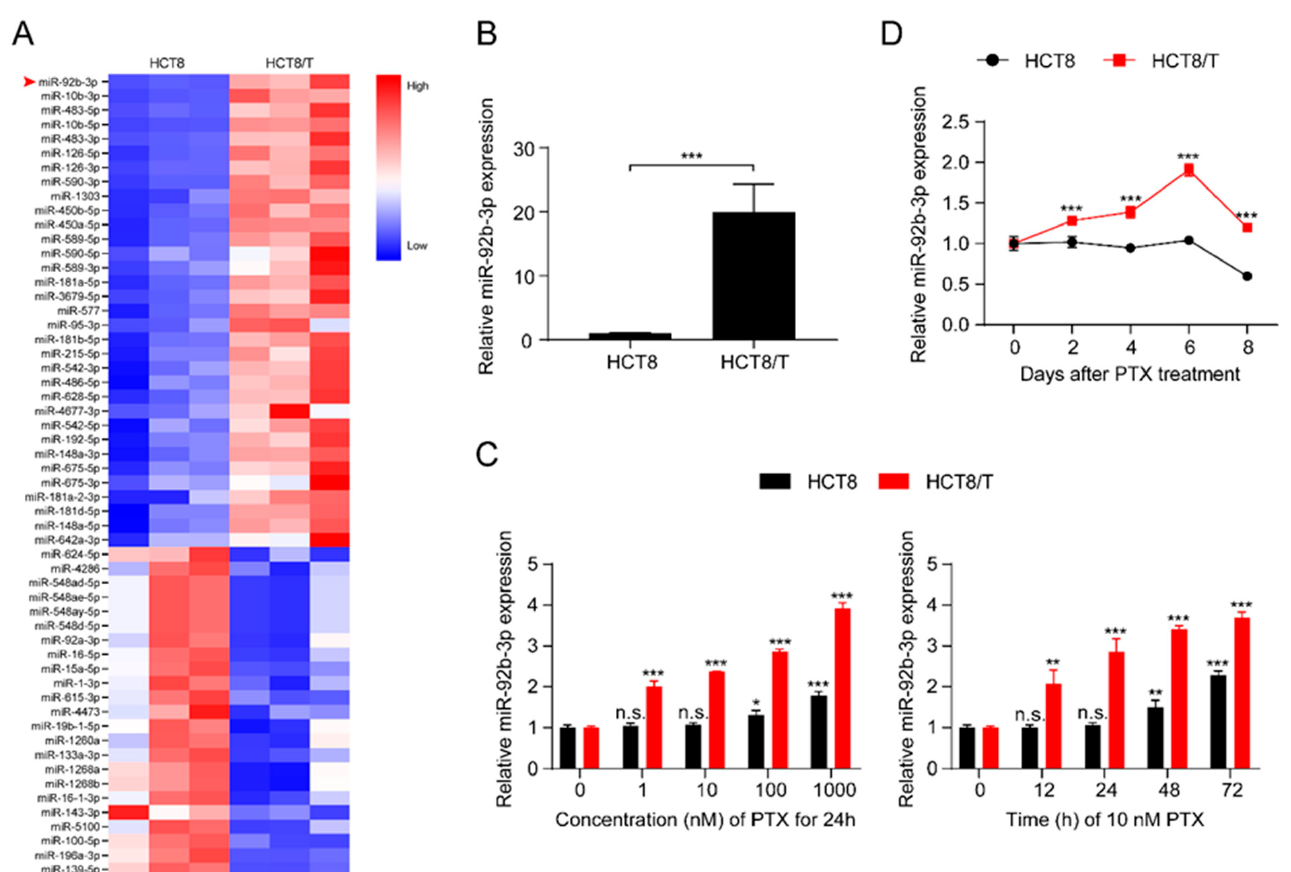
Figure 1. miR-92b-3p is highly expressed in HCT8/T cells and induced by PTX. ( A ) Heatmap of miRNAs expression profiling in HCT8 and HCT8/T cells measured. The red-white-blue color scale represents the normalized expression value of miRNAs: low expression (blue), medium expression (white), and high expression (red). ( B ) qRT-PCR analysis of relative expression levels of miR-92b-3p in HCT8 and HCT8/T cells. *** p < 0.001. ( C ) qRT-PCR analysis of relative expression levels of miR-92b-3p in HCT8 and HCT8/T cells treated with different concentrations of PTX for 24 h and 10 nM PTX for different time. versus cells without PTX treatment, respectively, n.s. p > 0.05; * p < 0.05; ** p < 0.01; *** p < 0.001. ( D ) qRT-PCR analysis of relative expression levels of miR-92b-3p in HCT8 and HCT8/T cells over time after treatment with 10 nM PTX for 72 h. versus HCT8 cells, *** p < 0.001. All experiments above were repeated three or more times independently and values are shown as mean ± SD.